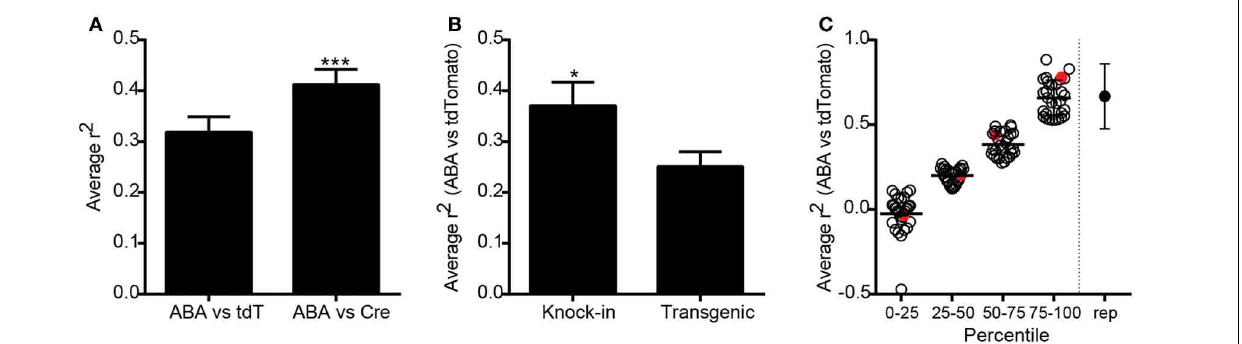
FIGURE 3 | Overall correlations between Cre expression and corresponding endogenous gene expression across all Cre lines. (A) Expression energy values across 295 annotated structures covering the entire brain were correlated between tdTomato or Cre ISH datasets, and each endogenous gene profile corresponding to the unique promoter driving Cre expression from the Allen Brain Atlas (ABA). The average correlation between ABA and tdTomato datasets was positive ( n = 119 lines, r 2 = 0 . 32, Spearman correlation). The average correlation between ABA and Cre ISH datasets was significantly higher ( n = 83 paired lines,